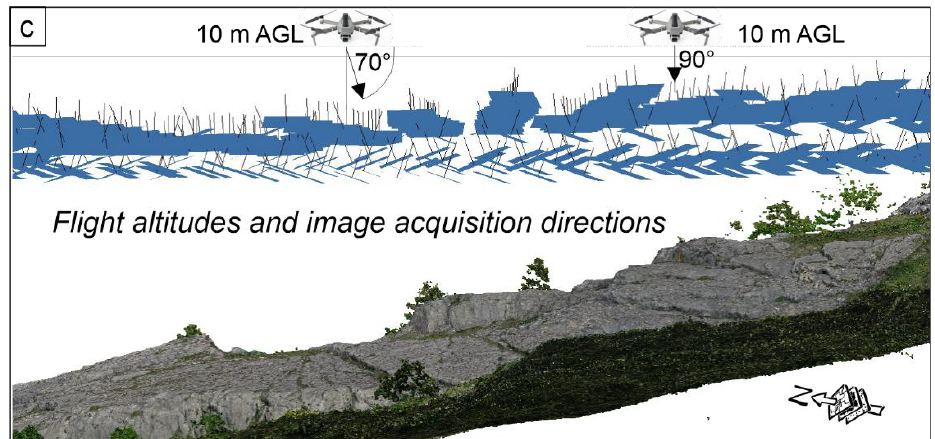
Figure 2. ( a ) Overview of the working methodology and the instruments used for the aerophotogrammetric survey: ( a 1 ) Remote controller with Apple iPad; ( a 2 ) Base station Emlid Reach RS2 GNSS/RTK L1,L2,L5 system; ( a 3 ) DJI Mavic 2 Professional with Antenna Topodrone GNSS L1,L2 RTK/PPK; ( a 4 ) Ruler 1 m; ( a 5 ) Ground Control Points GCPs; ( a 6 ) Aluminum telescopic ruler 5 m. ( b ) Location of the images (small white circles) acquired during the flight missions for areas A, B, C, and Tot. ( c ) Example of the positioning of the aircraft above area A. For more details on the three areas, A, B, C, see Figure S2.